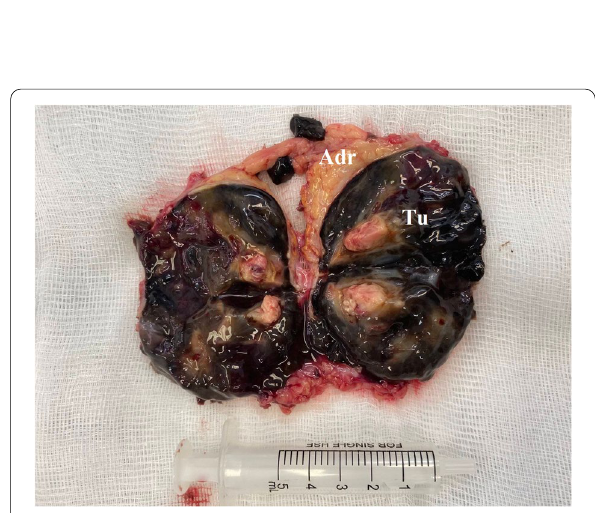
Fig. 4 Macroscopic appearance—shining surface, intact adrenal gland—above; Adr—adrenal gland;